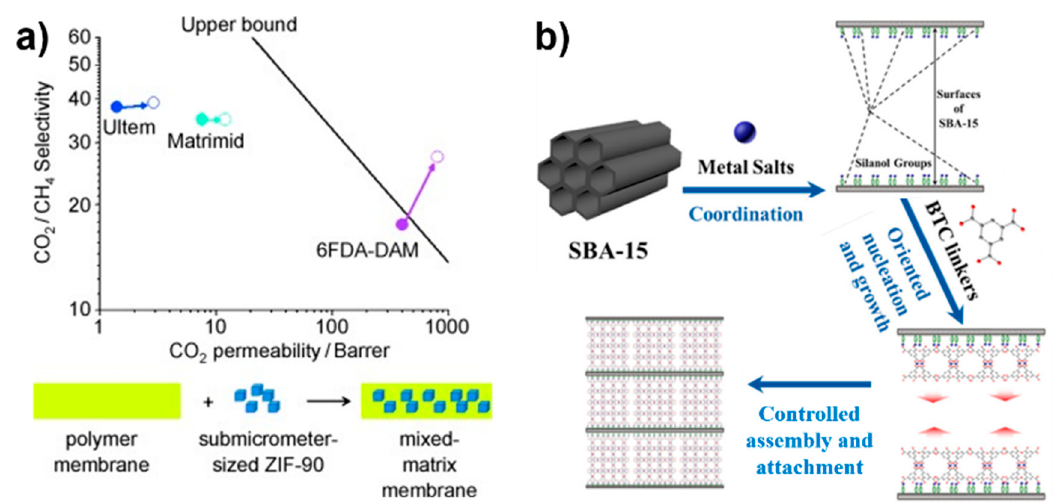
Figure 5. ( a ) MOF ‐ polymer hybrid membranes prepared by lay ‐ by ‐ layer deposition and their Figure 5. ( a ) MOF-polymer hybrid membranes prepared by lay-by-layer deposition and their enhanced enhanced performances. ( b ) The in situ growth of HKUST ‐ 1 on SBA ‐ 15. Reproduced with permission performances. ( b ) The in situ growth of HKUST-1 on SBA-15. Reproduced with permission from Bae et al. [70] (Copyright 2010 John Wiley and Sons) and Chen et al. [82] (Copyright 2017 American Chemical Society), respectively.